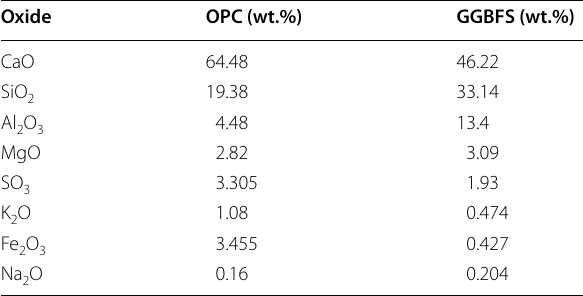
Table 1 Chemical oxide compositions of raw